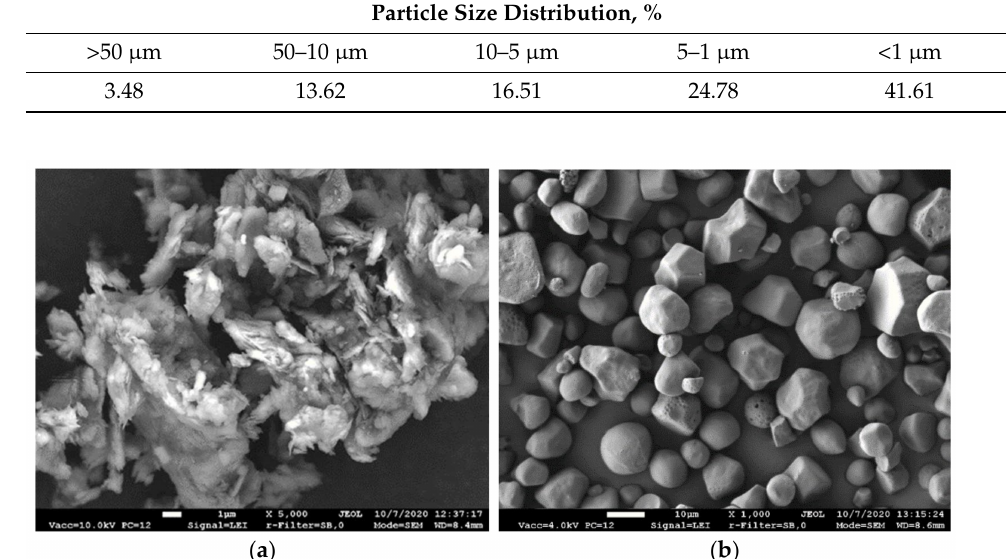
Figure 1. Microstructure of the raw materials: ( a ) clay and ( b ) primary starch. Starch is a hydrophilic gelling material, formed by two types of polymers: amylose and amylopectin. The native corn starch used in this study is a natural polysaccharide with 63% amylopectin and 26% amylose content. This starch was produced by the “Roquette”, in France. The raw starch in question has the following characteristics: bulk density— 550 kg/m 3 , compressibility—40%, and gelatinization temperature of 60–65 ◦ C. Figure